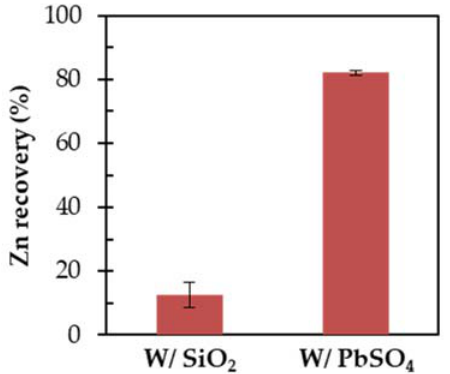
Figure 2. Flotation results of ZnS with SiO 2 or PbSO 4 .